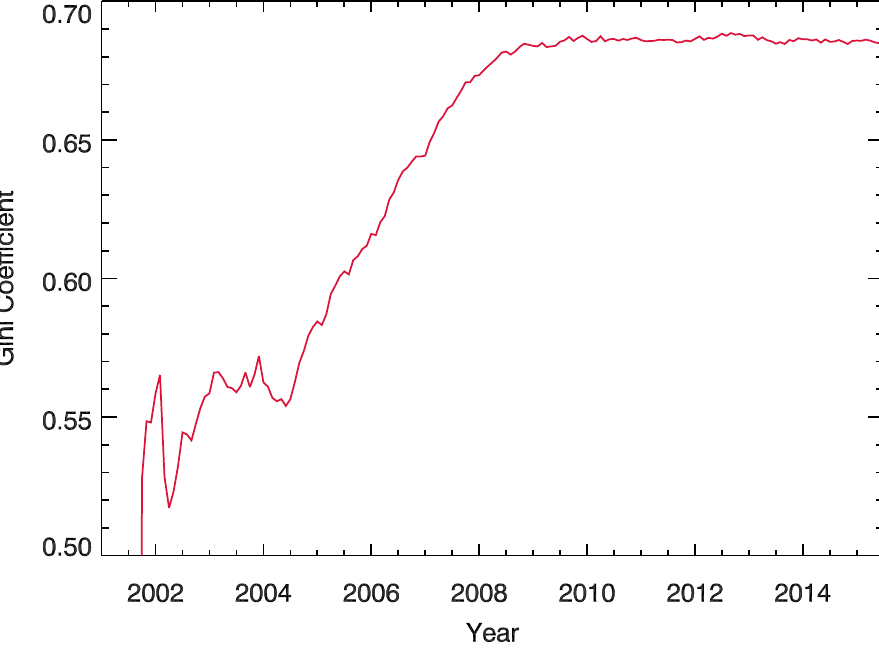
Figure 2. Evolution of the Gini coefficient over time. As new pages enter the system, overall network inequality increases, stabilizing in